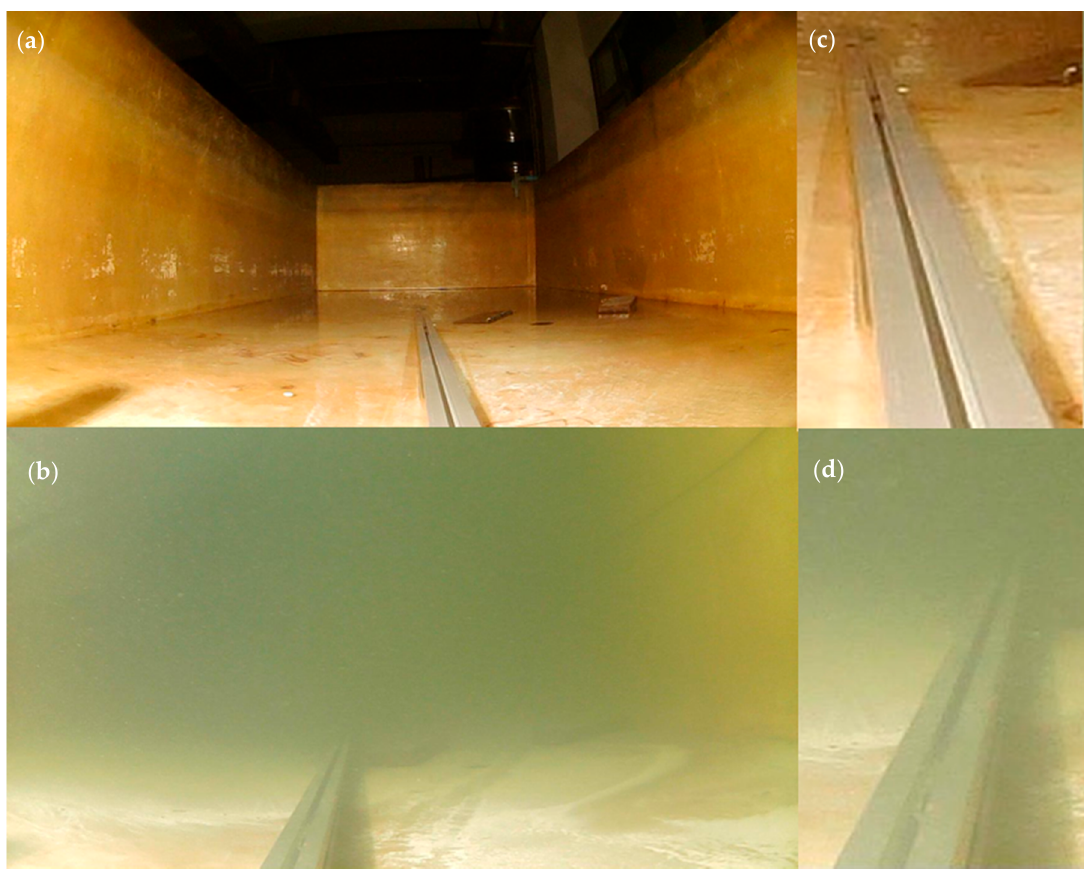
Figure 14. Target object in ( a ) the out-of-water environment (illuminance of 3.24 lux); and ( b ) the underwater environment (turbidity of 3.31 NTU and illuminance of 3.24 lux); and images of ROI in ( c ) the out-of-water environment; and ( d ) the underwater environment.